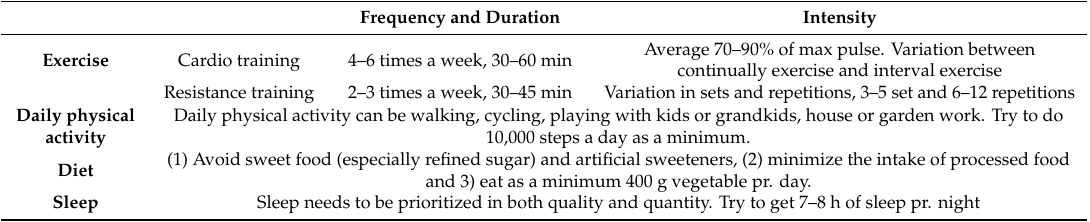
Table 1. Lifestyle guidelines recommended to experimental group after the U-TURN intervention.